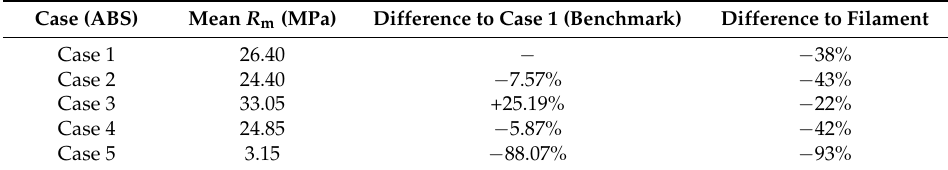
Table 9. The comparison of the mechanical properties of ABS test specimens with those of the filament. Case (ABS) Mean R m (MPa) Difference to Case 1 (Benchmark) Difference to Filament